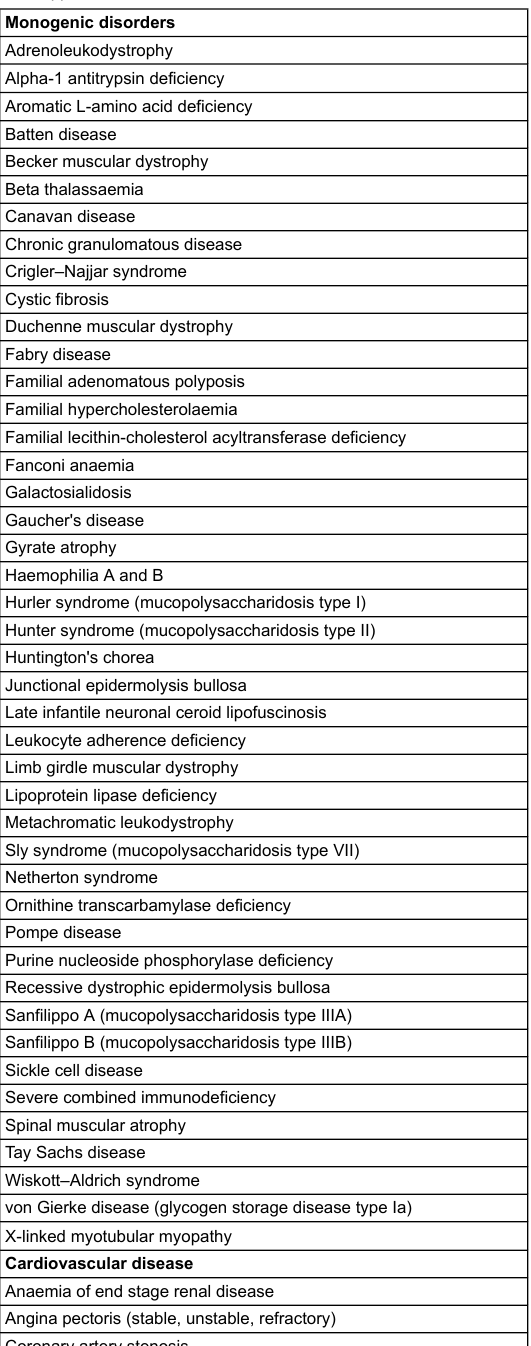
Table 1: Clinical conditions for which human gene transfer trials have been